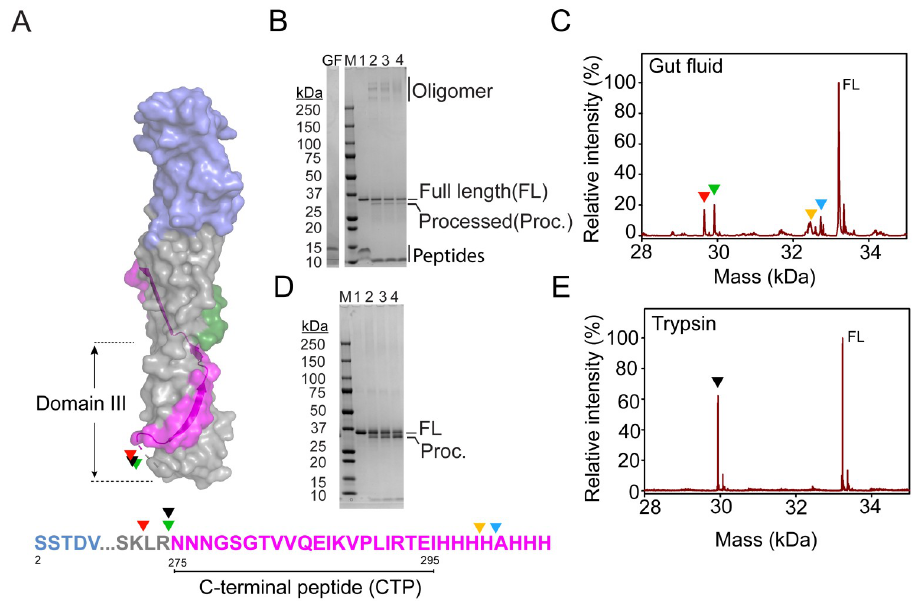
Fig 7. Protease processing of Mpp75Aa1.1 carboxyl-terminal peptide (CTP) yields a stable core with the propensity to form oligomers. (A) Surface rendition of Mpp75Aa1.1 domain III. The CTP is in magenta. Protease cleavage sites are colored arrowheads on the surface structure as well as on the primary amino acid sequence. (B) In vitro time course of Mpp75Aa1.1 proteolytic processing with WCR gut fluid at pH 6.0. Gut fluid (GF) only and oligomer formation are indicated. Lane 1 indicates unprocessed Mpp75Aa1.1; lane 2, lane 3, and lane 4 are processed Mpp75Aa1.1 at 10 min, 30 min, and 60 min, respectively. (C) Mass spectrometry profile of in vitro processed Mpp75Aa1.1 with WCR gut fluid. Cleaved polypeptide fragments are indicated by red (29.67 kDa), green (29.94 kDa), yellow (32.61 kDa), and cyan (32.75 kDa) arrowheads. (D) In vitro time course of Mpp75Aa1.1 proteolytic processing using trypsin. Lane 1 represents unprocessed Mpp75Aa1.1; lane 2, lane 3, and lane 4 are processed Mpp75Aa1.1 at 10 min, 15 min, and 30 min, respectively. (E) Mass spectrometry profile of in vitro processed Mpp75Aa1.1 with trypsin. Processed polypeptide is indicated by the black (29.94 kDa) arrowhead.